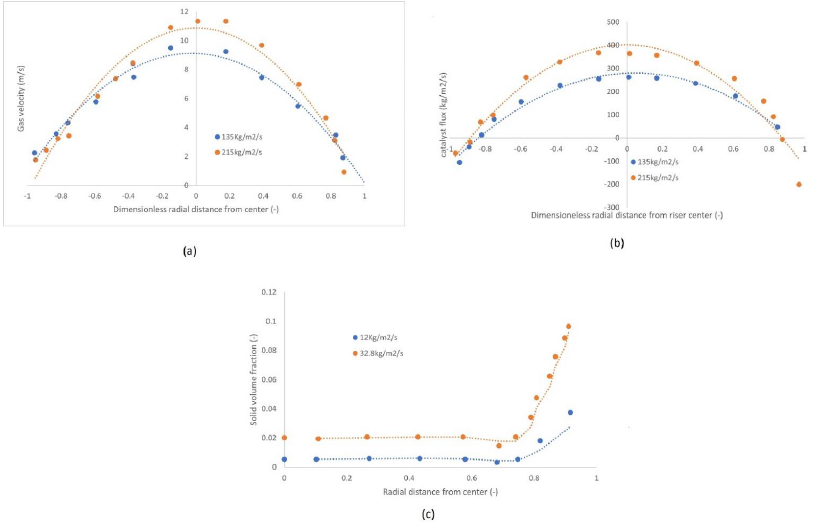
Figure 8. ( a ) Radial gas velocity profiles, (redrawn with data from [153] for Ug = 5.2 m/s) ( b ) radial profiles of catalyst flux, (redrawn with data from [153] for Ug = 5.2 m/s) and ( c ) Radial solid volume profile (redrawn with data from [154] for Ug = 2.89 m/s), for different solid